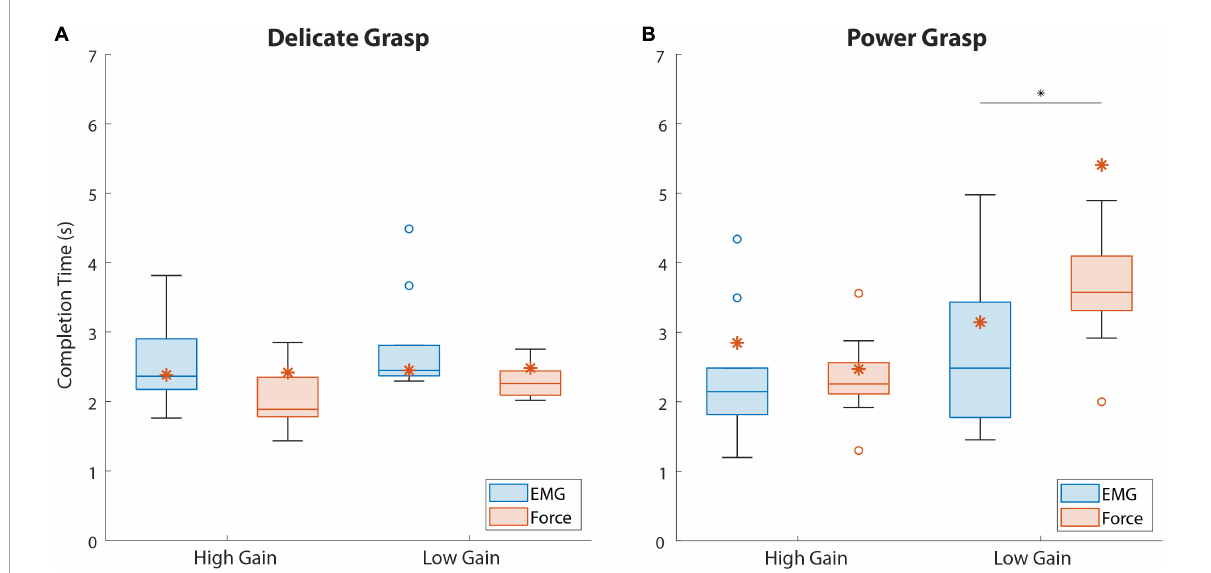
FIGURE7 The last attempt completion time for both force targets. Boxplots (A,B) correspond to delicate and power grasps, respectively. The blue and red boxplots represent the summary performance with EMG and force feedback, respectively. The orange asterisks denote the performance of the amputee subject. The boxplots indicate the median (horizontal line), interquartile range (boxes), min/max values (whiskers), and outliers (circles). Statistically significant pairs are marked with horizontal bars ( ∗ p < 0.05). “High Gain” and “Low Gain” denote the disturbance